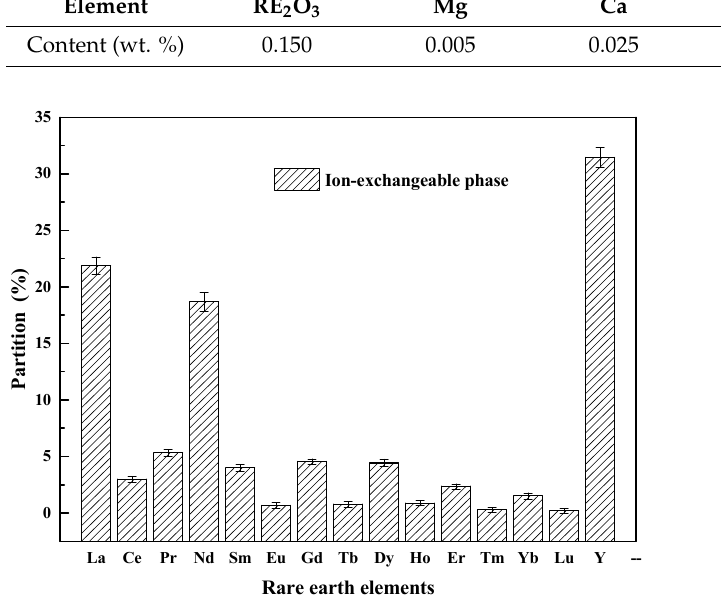
Table 1. Main chemical composition of the ion-exchangeable phase in the ICREO sample. Element